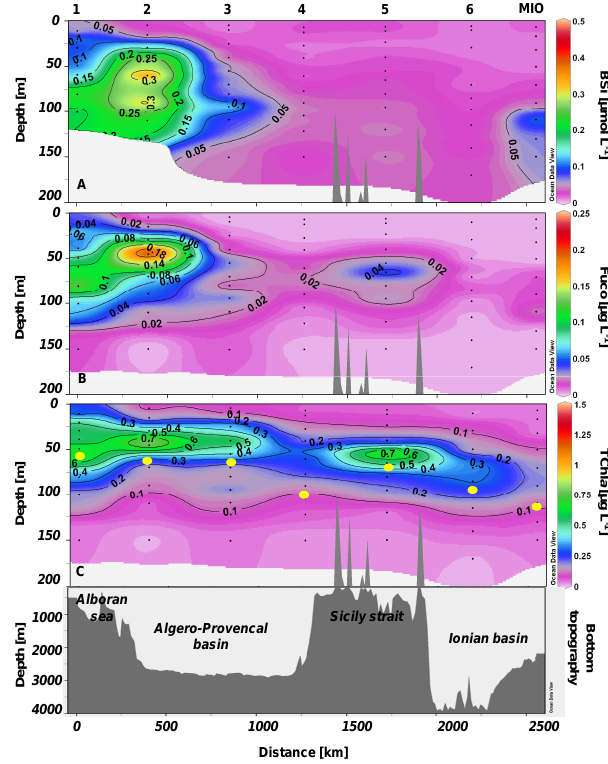
Fig. 5. Distribution of (A) Biogenic Silica (BSi) (µmolL − 1 ) , (B) Fucoxanthin (Fuco) (µgL − 1 ) , and (C) Total chlorophyll- a (TChl- a ) (µgL − 1 ) and depth (m) of the euphotic zone (yellow dots) along transect 1 during the PROSOPE cruise (summer/fall